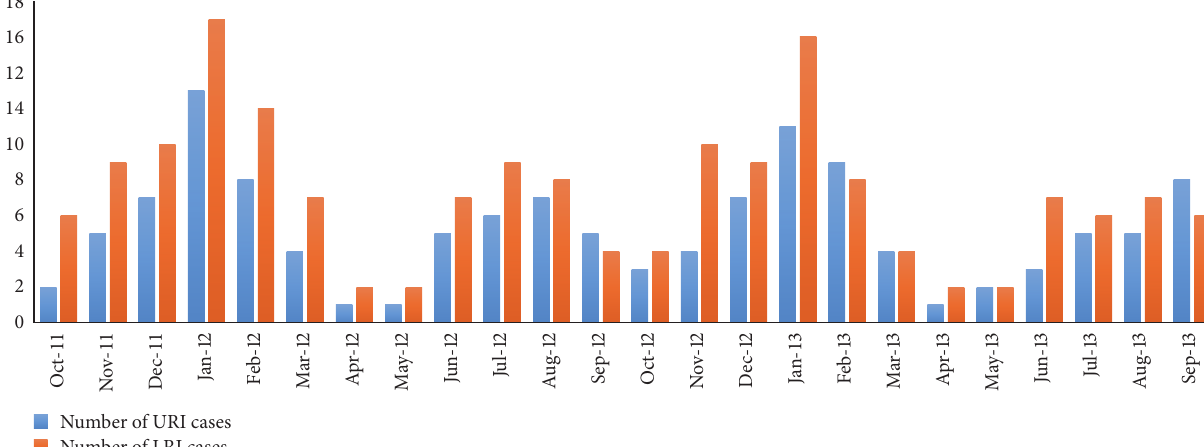
Figure 1: Month-wise recruitment of URI and LRI